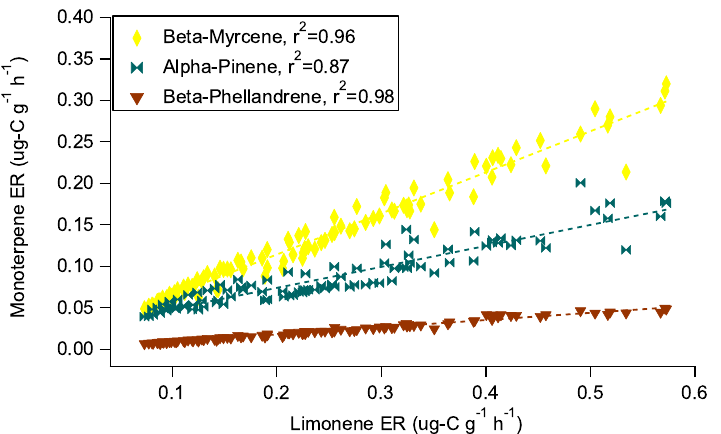
Figure 4. Covariance of constitutively emitted monoterpenes during the Picea pungens negative control experiment performed in July (PP- N).